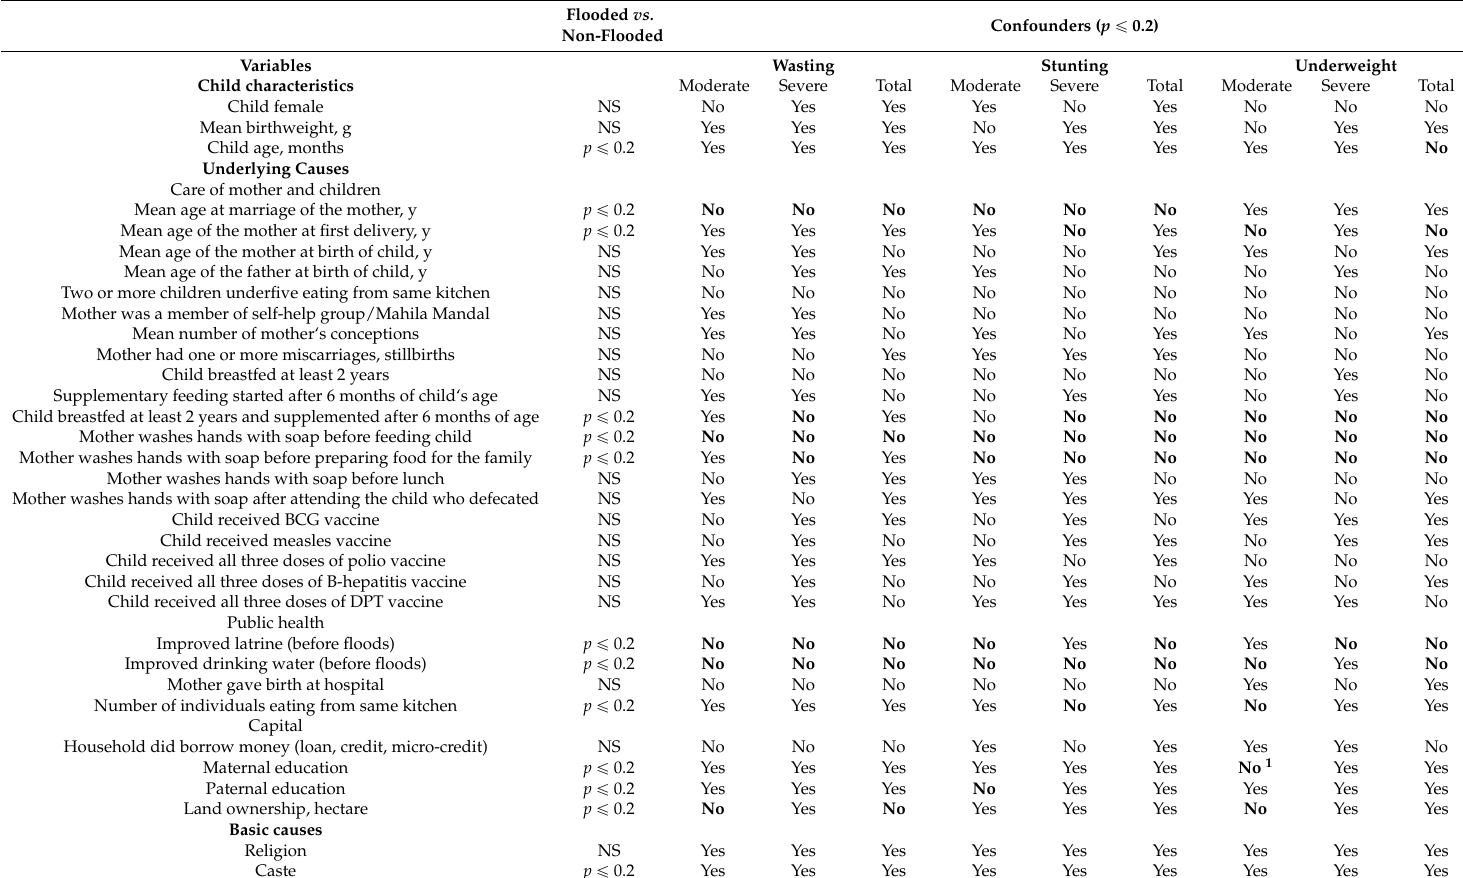
Table A1. Overview of variables with frequencies differing across exposure and plausible confounders of undernutrition indicators in children of rural Jagatsinghpur district, Odisha,